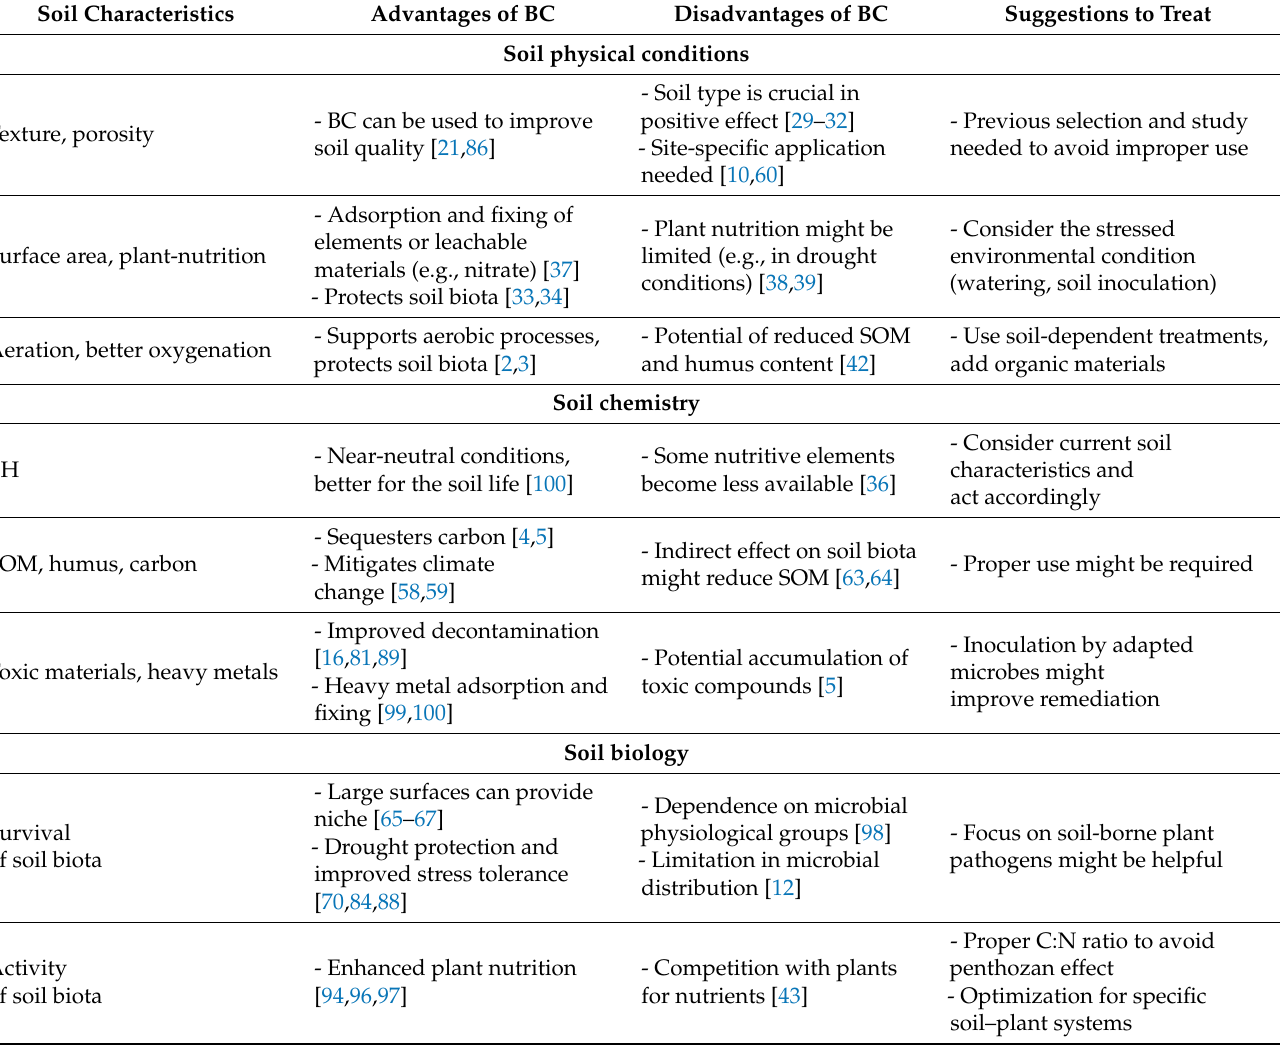
Table 5. Summary of possible advantages and disadvantages of biochar application in various soil–plant systems with suggested